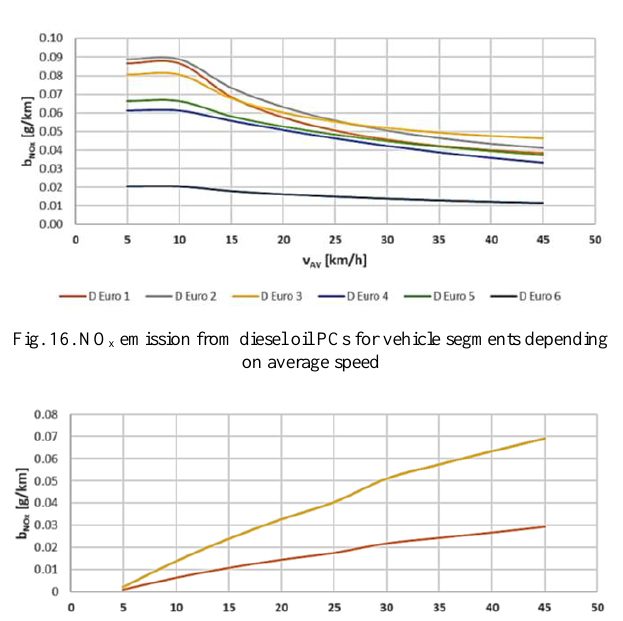
Fig. 15. NO x emission from petrol PCs for vehicle segments depending on average speed